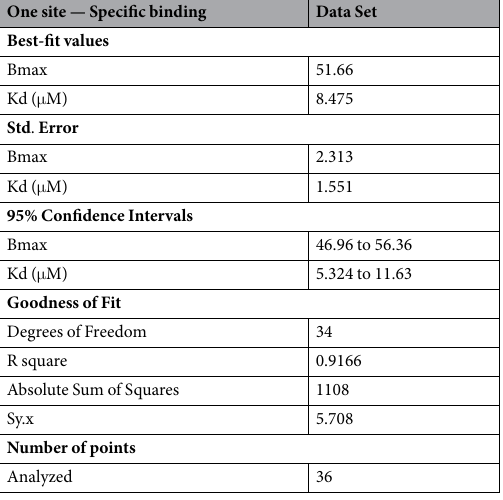
Table 1. K D value and statistics from fit to one site specific binding of UFM1-UIS.